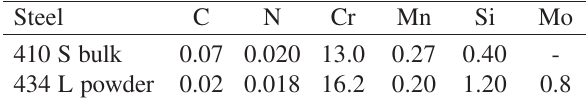
Table 1. Chemical composition of the alloys (wt.%).